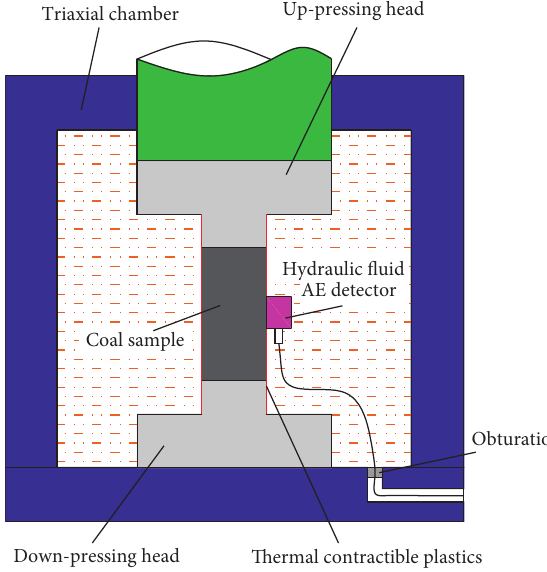
Figure 3: AE detector placed on the coal